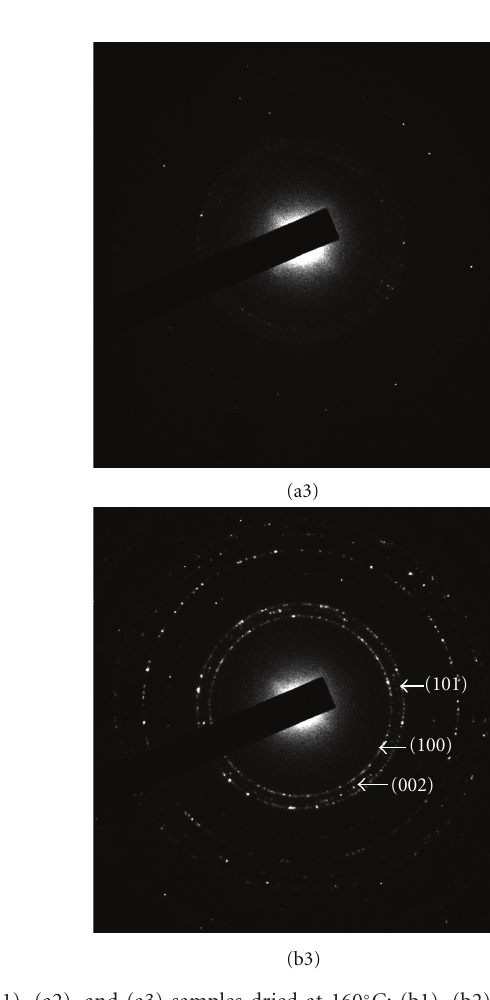
Figure 4: SAED graphs and FE-TEM images of ZnO fibers: (a1), (a2), and (a3) samples dried at 160 ◦ C; (b1), (b2), and (b3) samples calcinated at 500 ◦